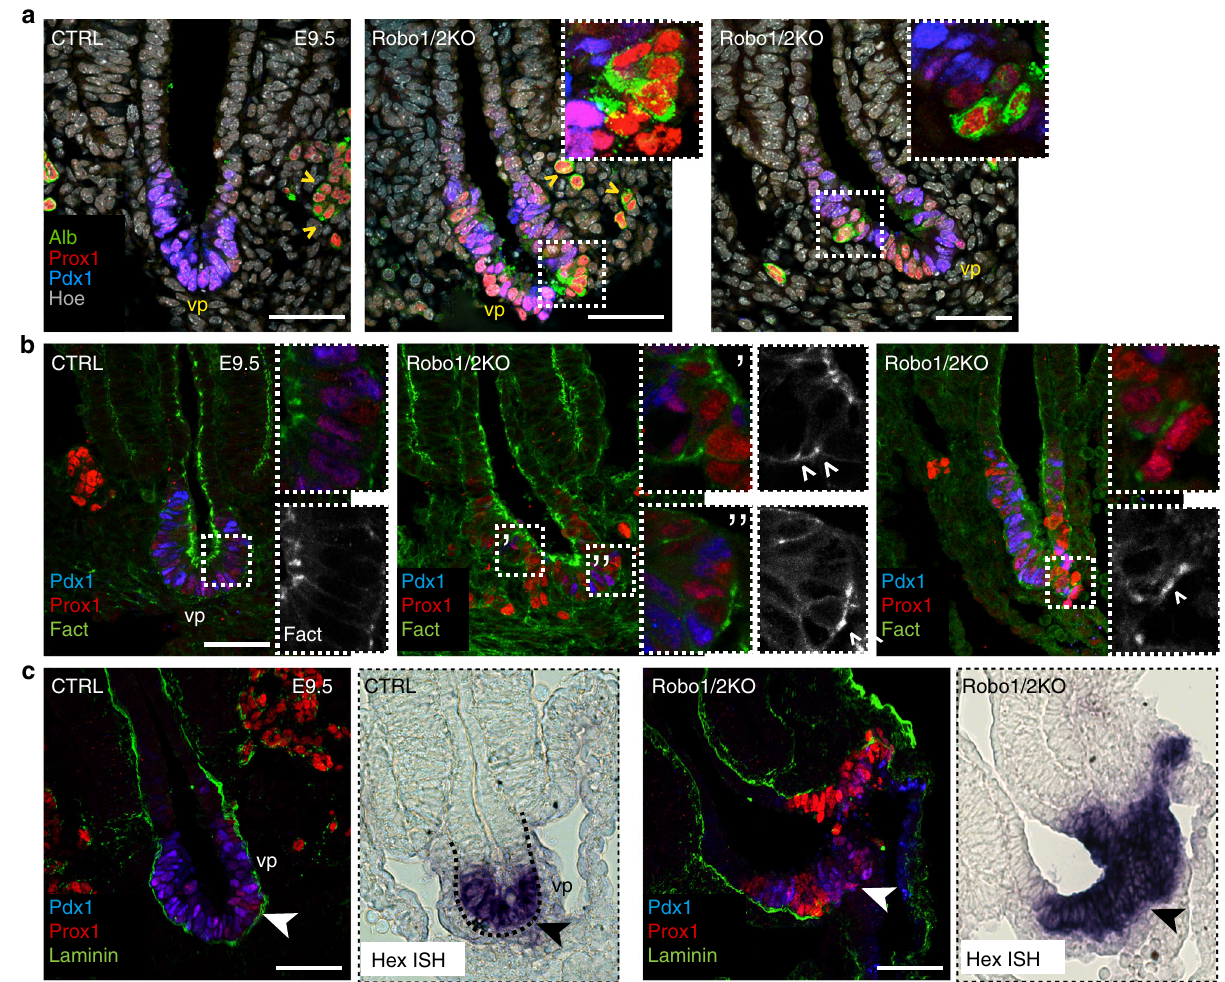
Fig. 4 In the absence of Robo1 and Robo2 pancreatic cells acquire an hepatoblast identity. a Representative IF images of E9.5 CTRL and Robo1/2 KO cryosections stained for Albumin (Alb), Pdx1 and Prox1. Hoechst (Hoe) was used as nuclear counterstain. Arrowheads indicate Prox1 + /Alb + liver progenitors in hepatic cords. In dashed box, Pdx1 - , Prox1 + and Alb + cells within the ventral pancreatic epithelium (vp) of KO embryos. Insets show boxed area at higher magni fi cation without Hoe channel. Scale bars, 50 µ m. b Representative IF images of E9.5 CTRL and Robo1/2 KO cryosections stained for Phalloidin (F-actin), Pdx1 and Prox1. Insets show boxed area at higher magni fi cation and Phalloidin (F-act) channel alone. Note the accumulation of F-actin at the lateral or basal surface of the mutant cells (arrowheads). c Representative IF images of E9.5 CTRL and Robo1/2 KO cryosections stained for Laminin, Pdx1 and Prox1. In boxed area, consecutive sections stained using antisense Hhex ISH probe. Arrowheads indicate laminin-enriched basal membrane surrounding the ventral pancreatic bud. Scale bars, 50 µ